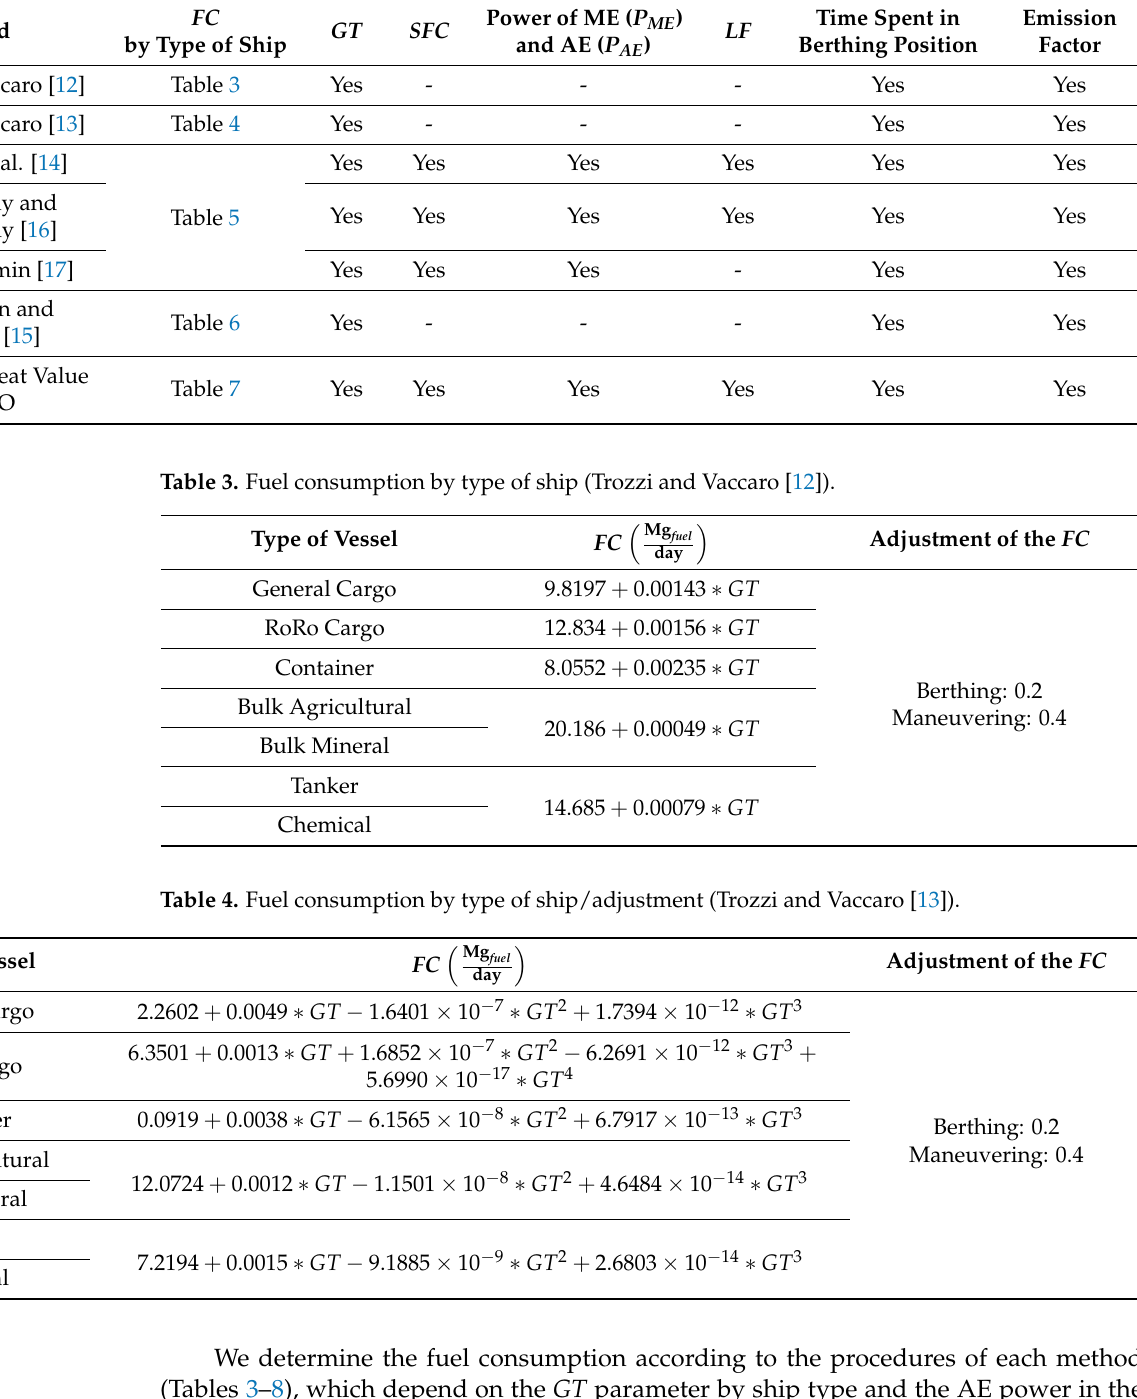
Table 2. Methods used in this study for estimating fuel consumption and atmospheric SO 2 emissions. Method Table 3 Table 4